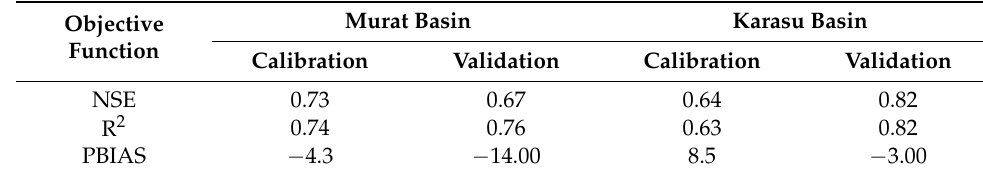
Table 7. Performance statistics of SWAT modeling (daily time-step).